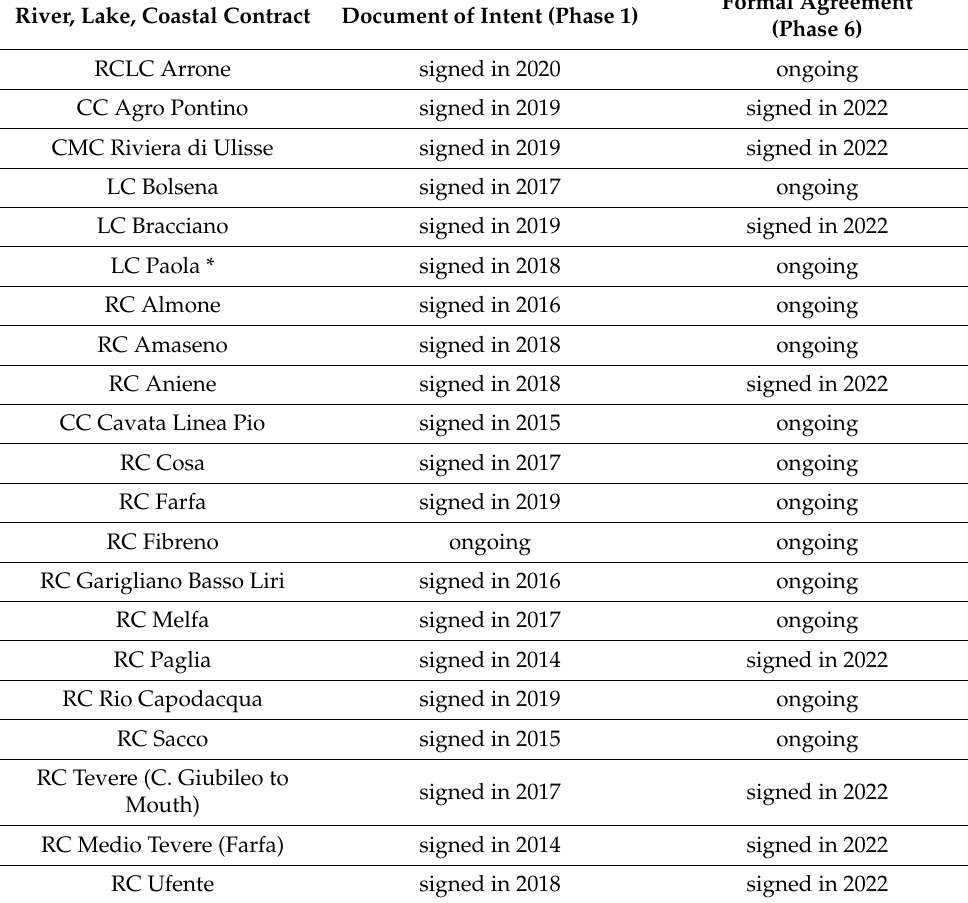
Table 1. River Contract (RC), Lake Contract (LC), Coastal Contract (CC), River Coast and Landscape Contract (RCLC) and Coast and Mouth Contract (CMC) in the Lazio Region. Source: authors’ elaboration (2022) from data of the national board on River Contracts available at http://www.a2 1fiumi.eu/ (accessed on 30 June